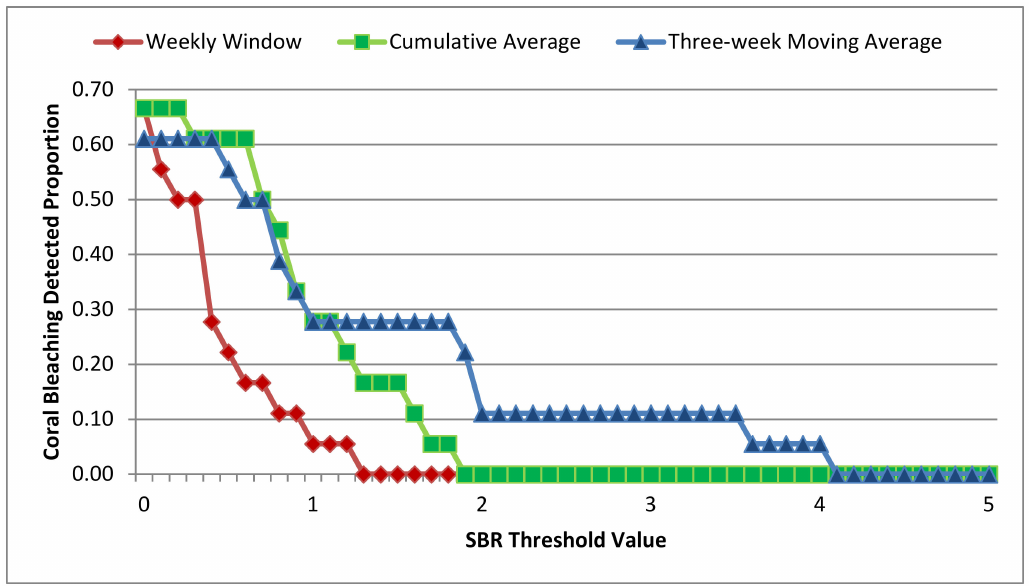
Figure 5. Response of detectability under multiple Standardized Bottom Reflectance (SBR) threshold values (data show the maximum SBR pixel value extracted within each location